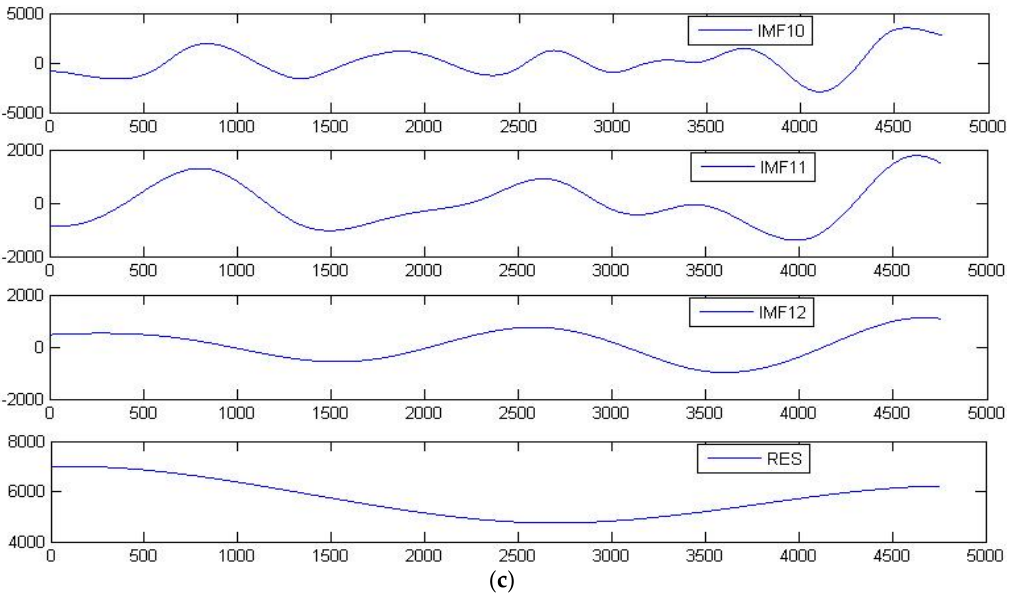
Figure 6. Runoff time-series and IMF (Intrinsic Mode Functions) signal components for validation dataset. ( a ) Original validation runoff time-series and first 4 IMF components; ( b ) IMF components 5 through 9; ( c ) IMF components 10 through 12 and the final residue. Table 3. Input variables LGP models in hybrid designs untilizing EEMD and SOM.